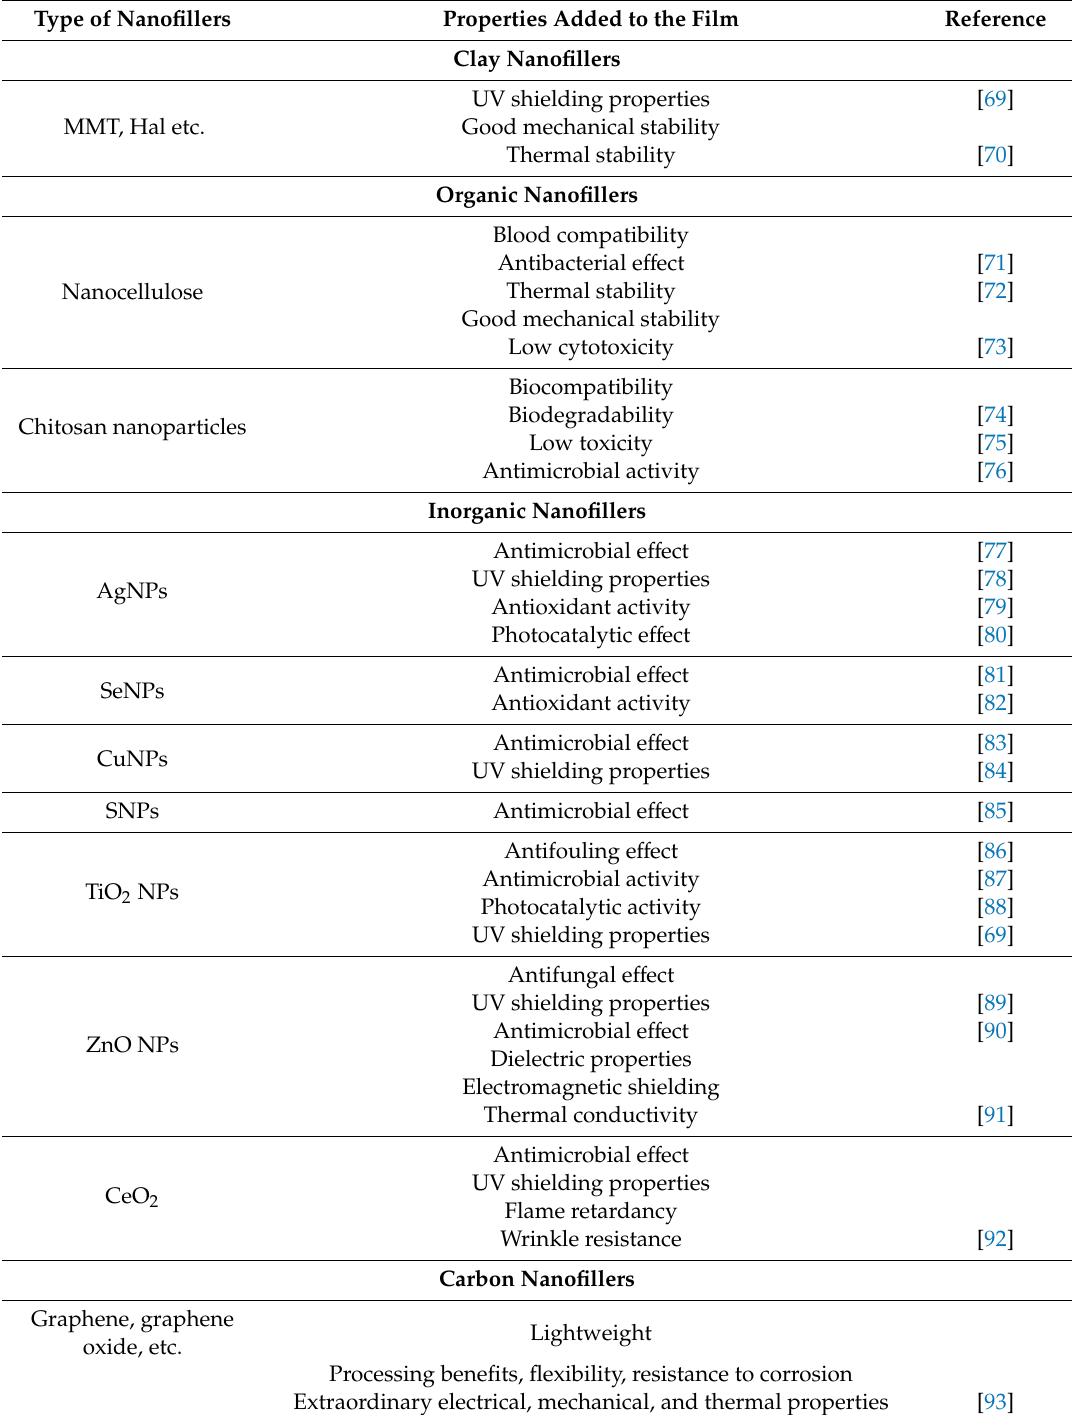
Table 2. Recent examples of nanofillers